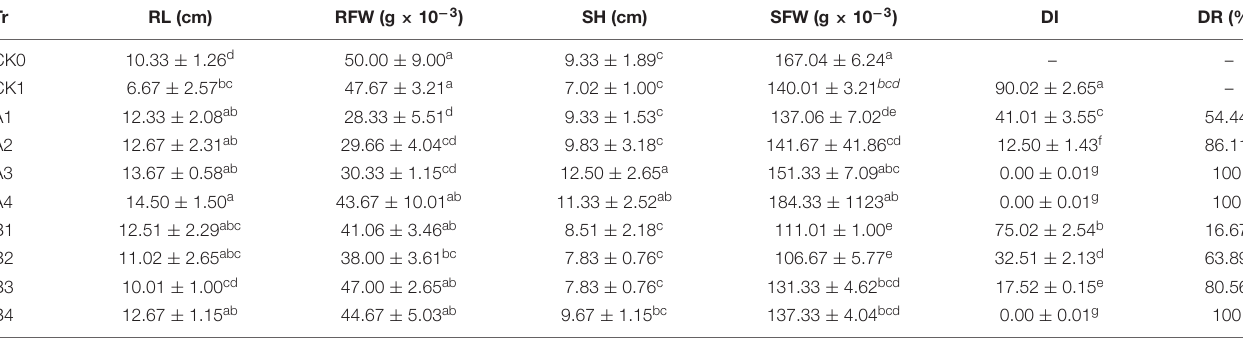
TABLE 1 | Biocontrol effect of different concentrations of fengycin and iturin A on wheat take-all disease.